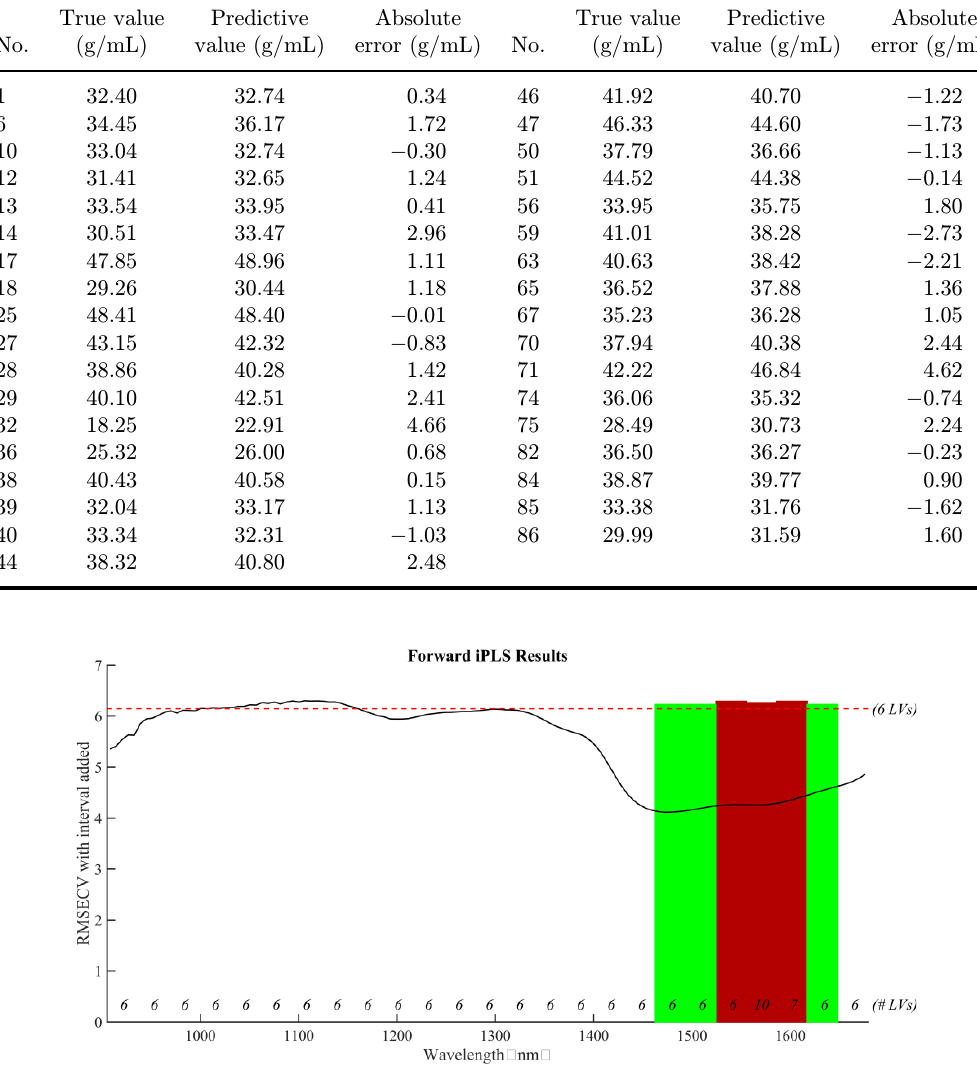
Fig. 7. The result of variable selection.